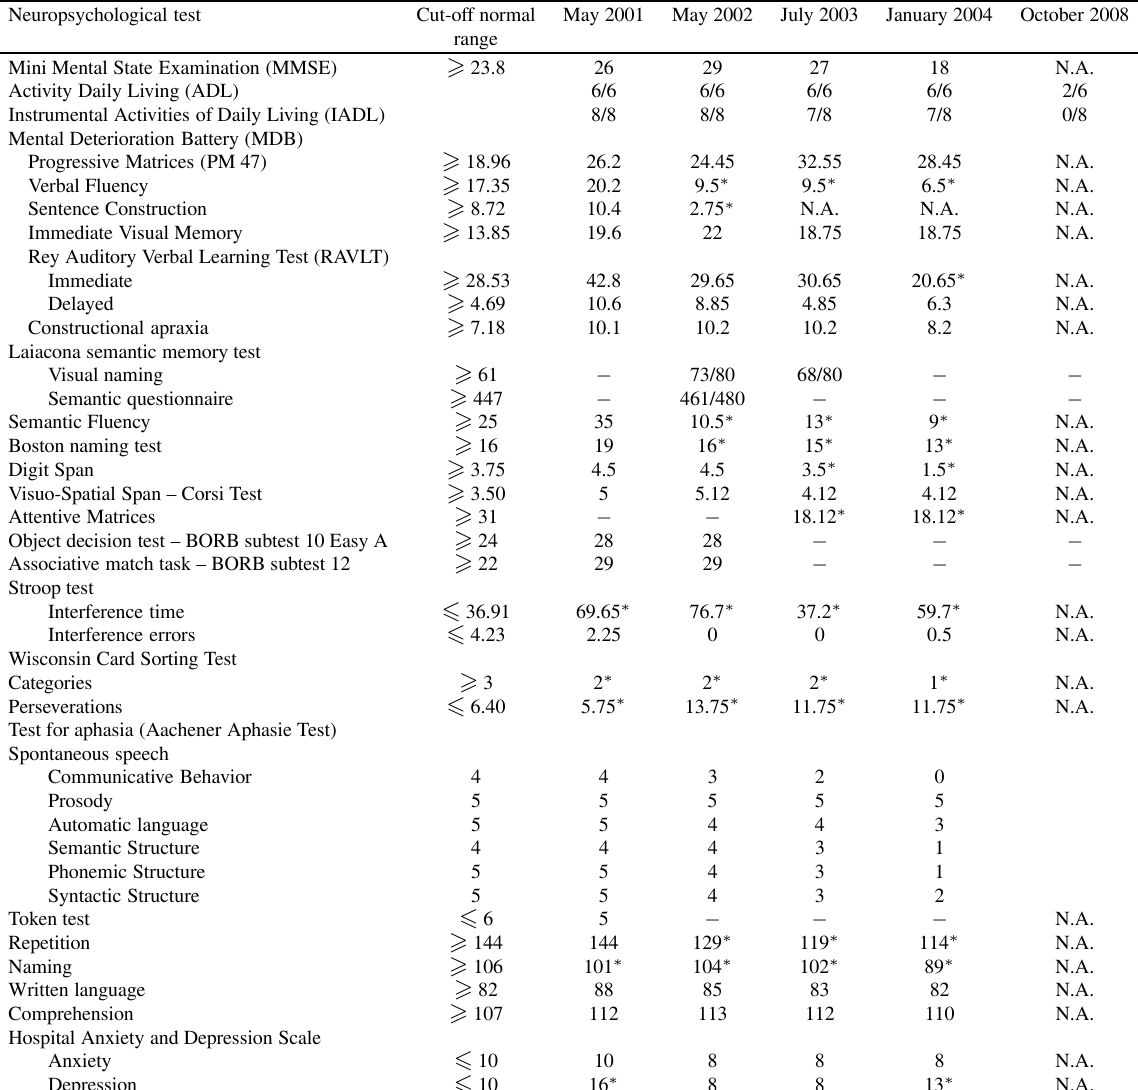
Table 1 Neuropsychological testing of the patient in the disease course